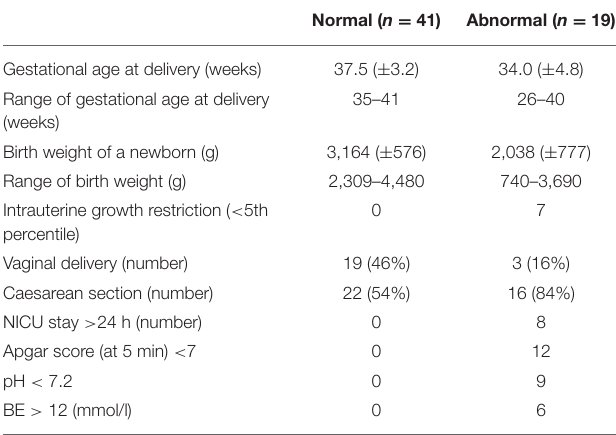
TABLE 4 | Descriptive statistics of the selected parameters, describing the labor and fetal outcome, presented separately for two groups of the research material, including 19 recordings with abnormal and 41 recordings with normal fetal